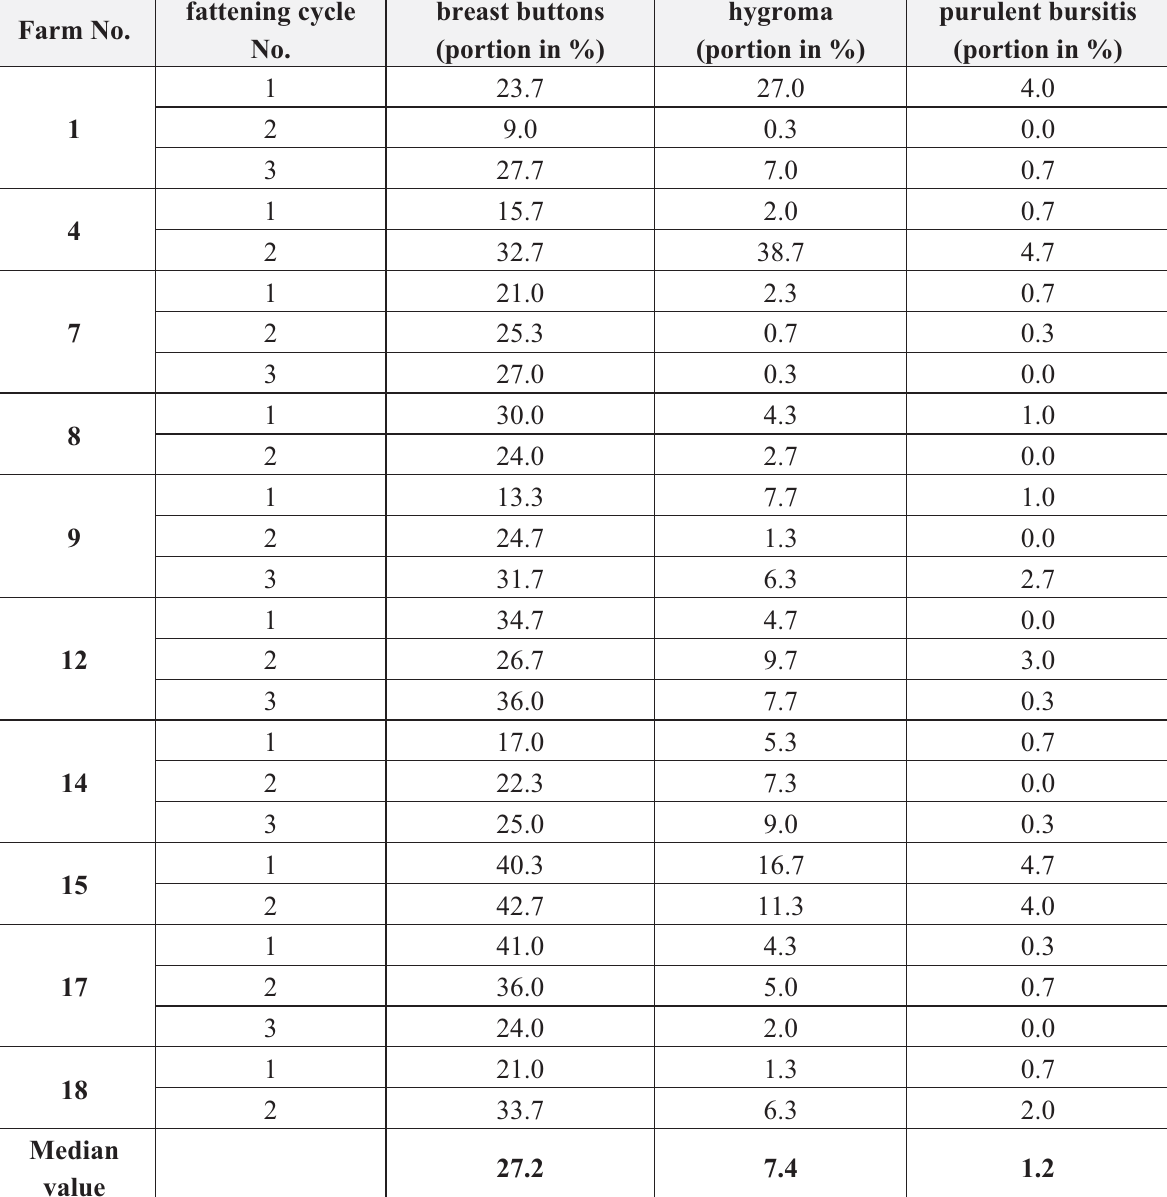
Table 2. Prevalence of breast skin alterations in male turkeys in meat examination. Individual value depiction arranged according to farms. Farm